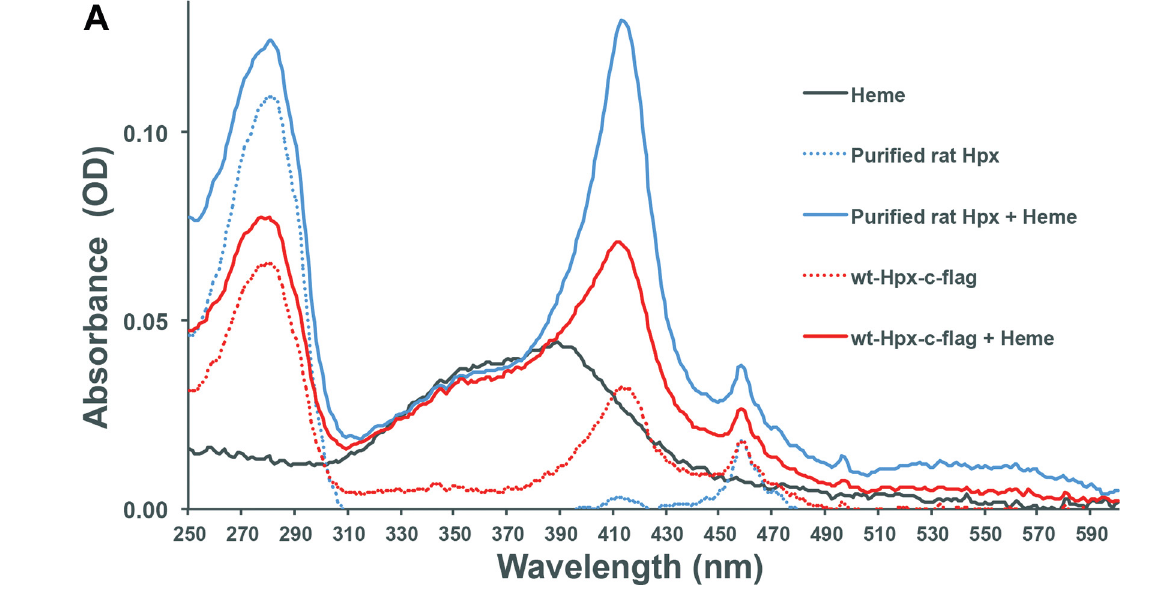
and ms-Hpx . Wt-Hpx-c-Flag, HM RM